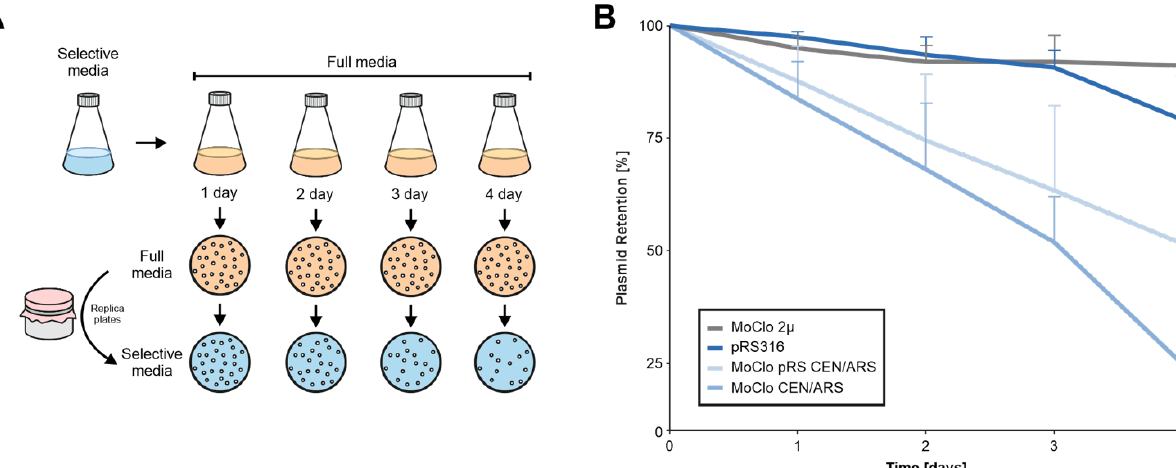
FIGURE 7: In the absence of selective pressure, the CEN/ARS MoClo plasmids are rapidly lost from yeast cultures. (A) Schematic overview of the experimental setup. Cells were transformed with the four indicated plasmids and first grown on minimal glucose media lacking uracil. After one day cells were shifted to full media, grown and maintained for several days. Each day 0.001 OD of cells were plated onto full media plates and subsequently replica plated on to minimal media plates to calculate the proportion of colonies that lost a plasmid. (B) Relative plasmid retention was calculated as the ratio of colonies on minimal media versus full media and normalized to day 0. The plot shows the mean values of five independent replicates (N = 5). The error bars represent the standard deviation. Standard deviation is only shown in one direction for better visibility of individual data